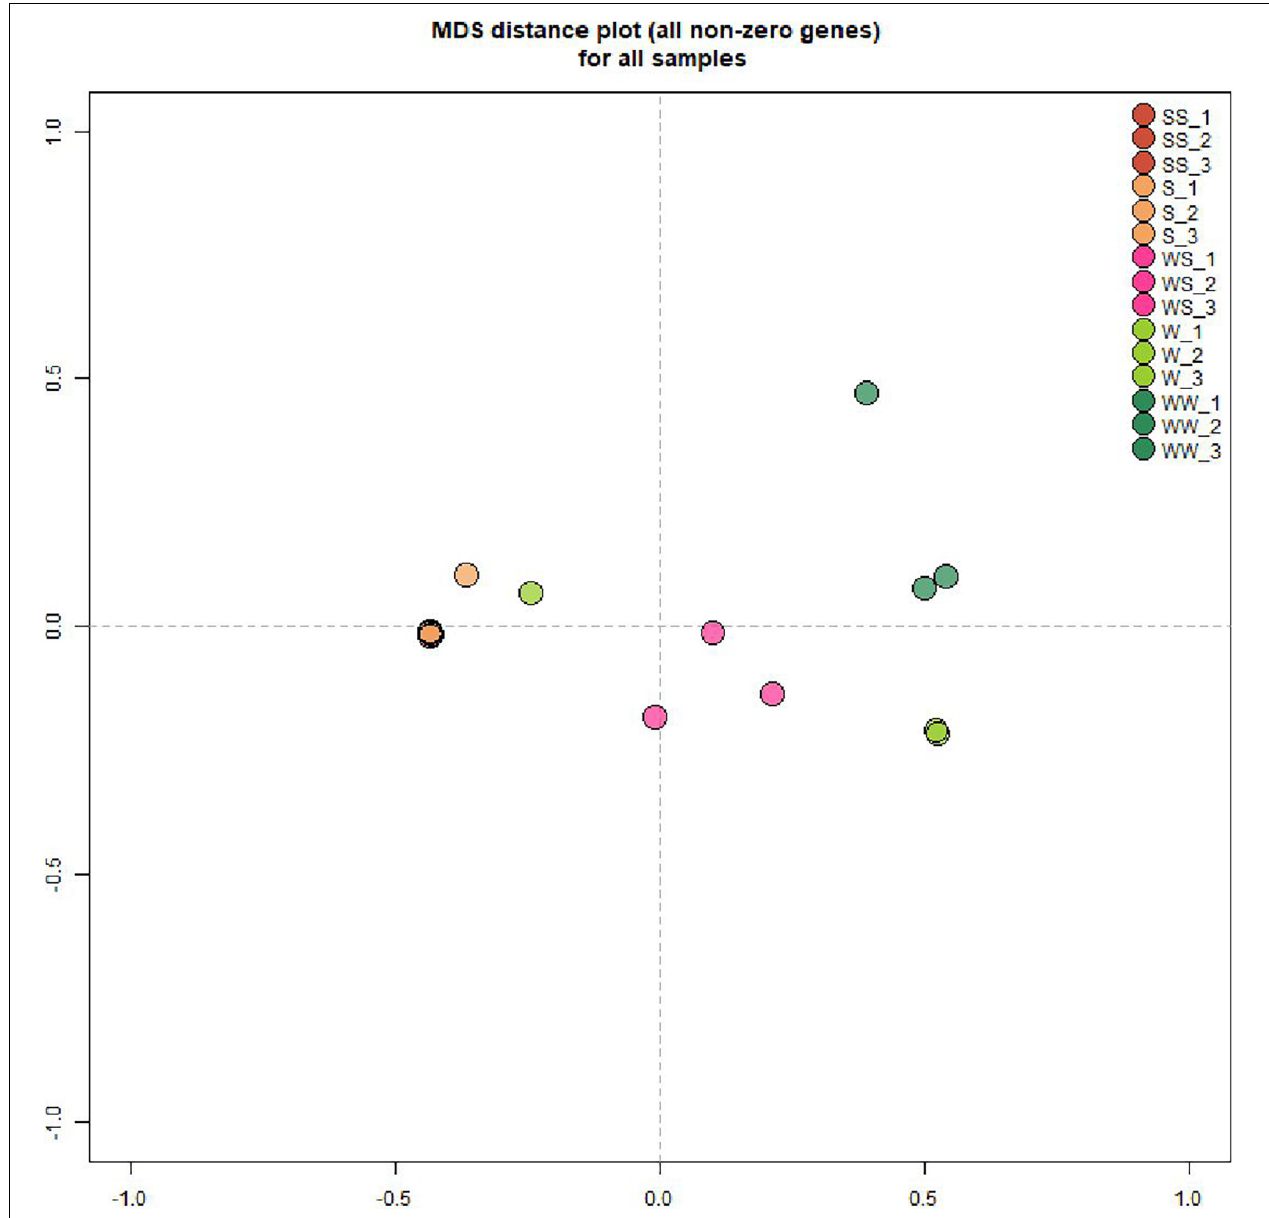
FIGURE 4 | Multidimensional Scaling (MDS) plots for grafted plants (WW, SS, an WS) vs. non-grafted controls (W, S). Worth mentioning are the results of WS samples which are positioned between squash and watermelon